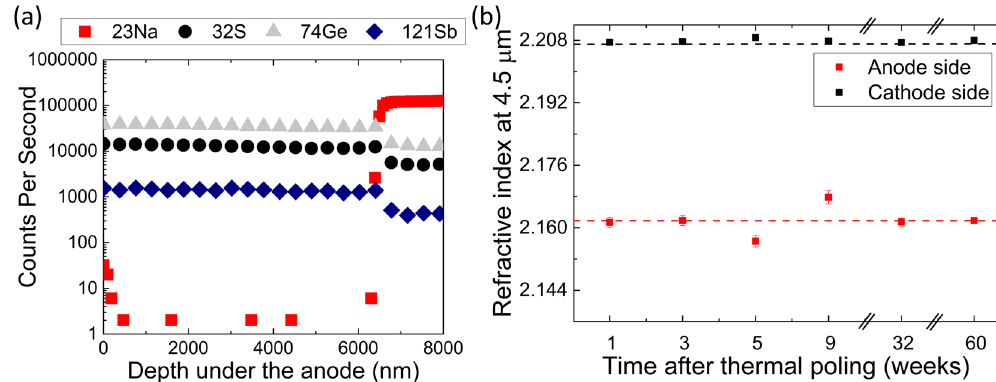
Figure 1. Secondary Ion Mass Spectrometry (SIMS) profile recorded on a glass doped with 3 mol% of Na 2 S after thermal poling ( a ) and refractive index values measured at λ = 4.5 µ m on the cathode and anode sides of a poled sample doped with 3 mol% of Na 2 S ( b ). Error of measurements are within the data point and the dashed line is presented as a guide to the